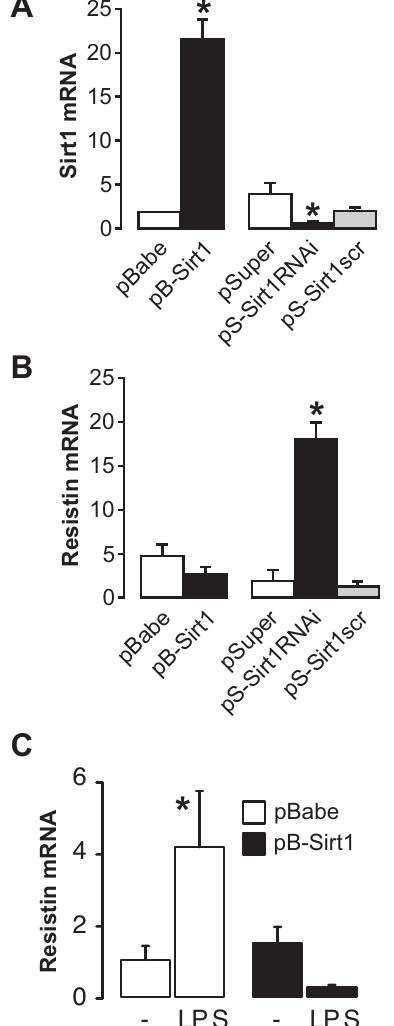
Figure 3. Downregulation of Sirt1 increases resistin expression in macrophages. Sirt1 (A) and resistin (B) mRNA levels in RAW264 macrophages infected with viruses for Sirt1 overexpression (pBabe- Sirt1) or downregulation (pSuper-Sirt1 RNAi) or their respective control vectors. Scr: scrambled sequence. (C) Resistin mRNA levels in pBabe- or pBabe-Sirt1-infected RAW264 macrophages treated for 24 h with or without LPS (1 m g/mL). Bars are representative of 3 experiments done in triplicate. In all panels, * indicates a significant difference between groups.